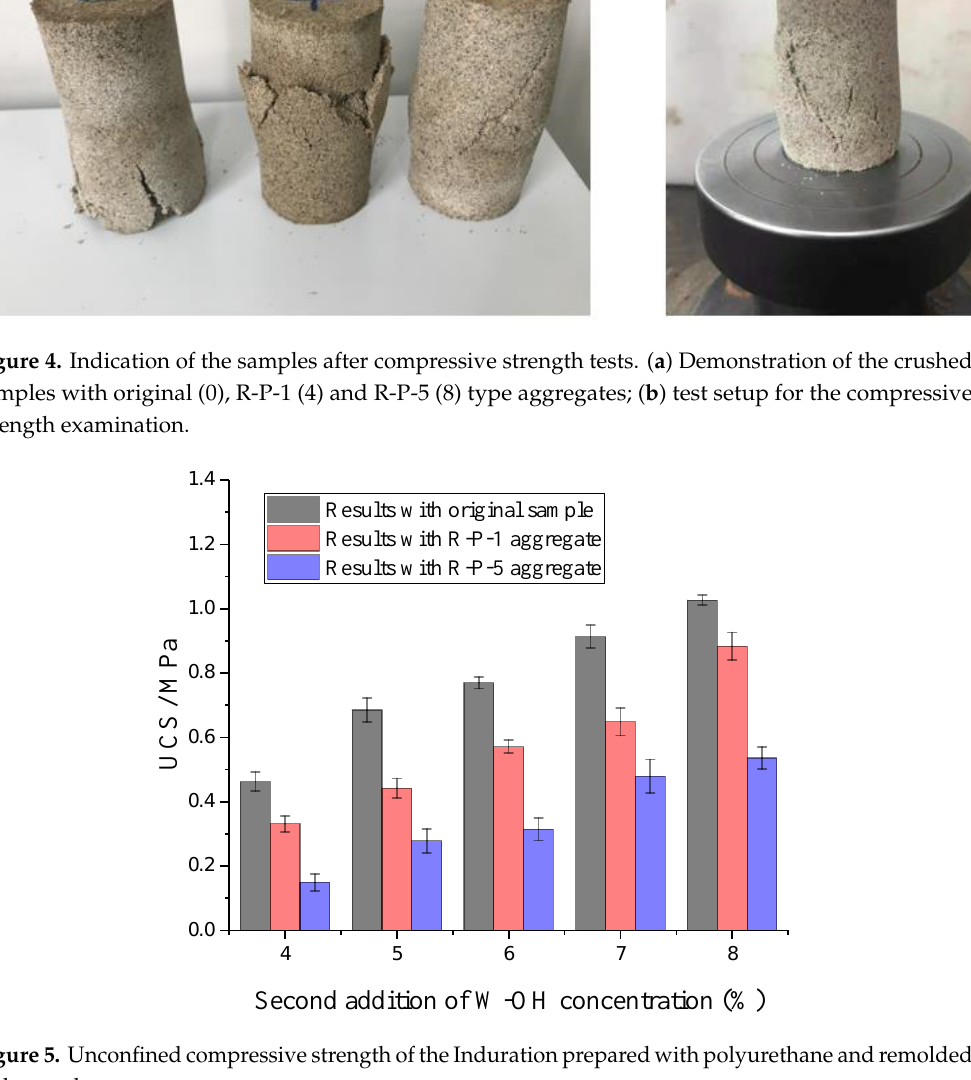
Figure 5. Unconfined compressive strength of the Induration prepared with polyurethane and remolded Pisha sandstone. Pisha